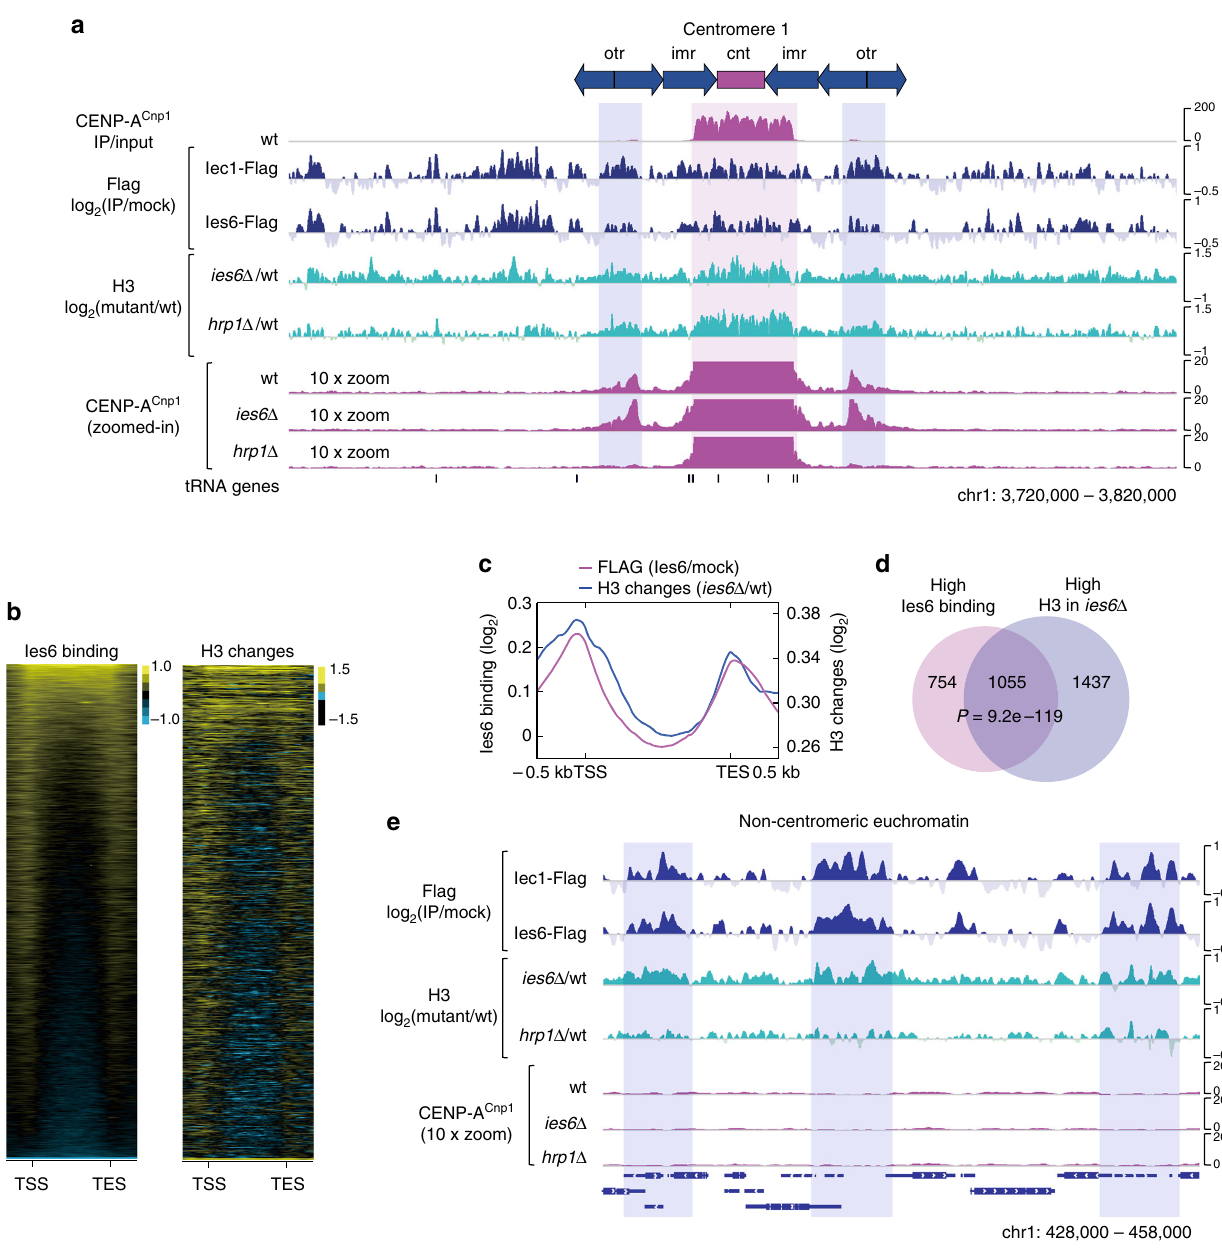
Fig. 2 The Ino80 complex induces removal of histone H3 from associated chromatin. a ChIP-Seq pro fi les of CENP-A Cnp1 , Iec1-5×Flag, and Ies6-5×Flag in wt cells, and the histone H3 changes in ies6 Δ and hrp1 Δ cells relative to wt at centromere 1. The ChIP enrichments for Flag-tagged Ino80 subunits were normalized to those in mock (no tag) cells. The H3 ChIP-Seq experiments were performed and analyzed using wild-type S. cerevisiae cells as external spike- in controls (see Methods for more detail). Magni fi ed (×10) views of CENP-A Cnp1 are shown below. The magenta and blue vertical shadings indicate